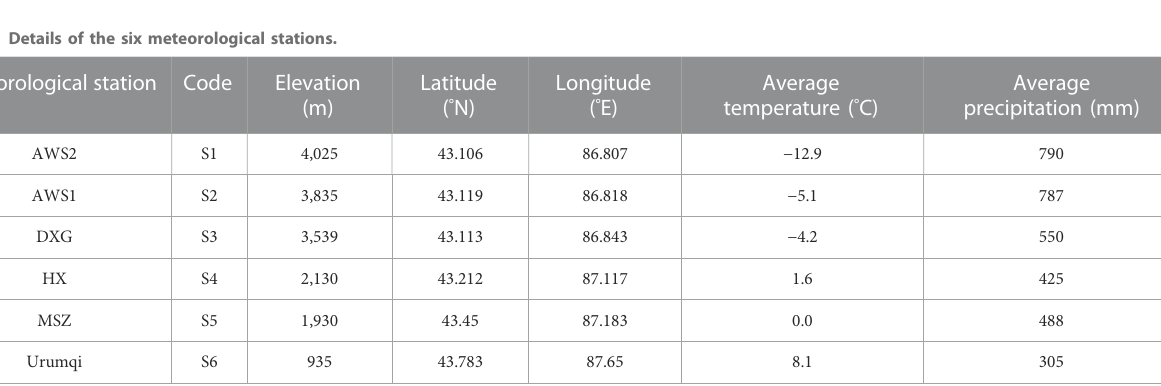
TABLE 1 Details of the six meteorological